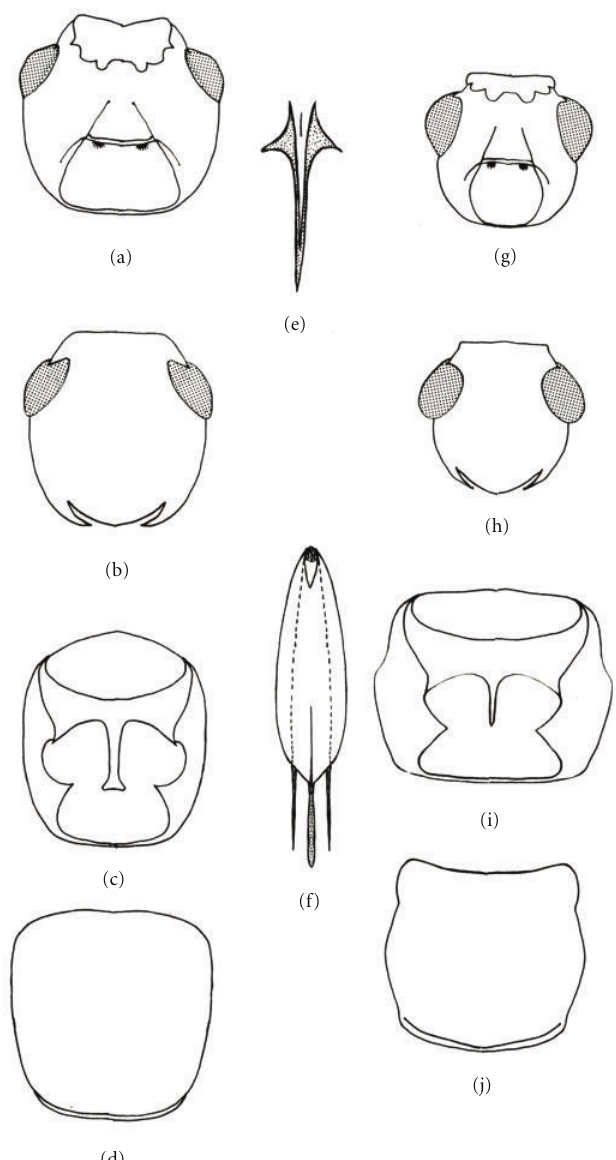
Figure 19: Various organs. (a)–(f) Thriocera pectoralis . (a, b) Head ((a) ventral, (b) dorsal). (c, d) Pronotum ((c) ventral, (d) dorsal). (e) Spiculum. (f) Aedeagus. (g)–(j) Thriocerodes bifasciatus . (g, h) Head ((g) ventral, (h) dorsal). (i) and (j) Pronotum ((i) ventral, (j) dorsal).